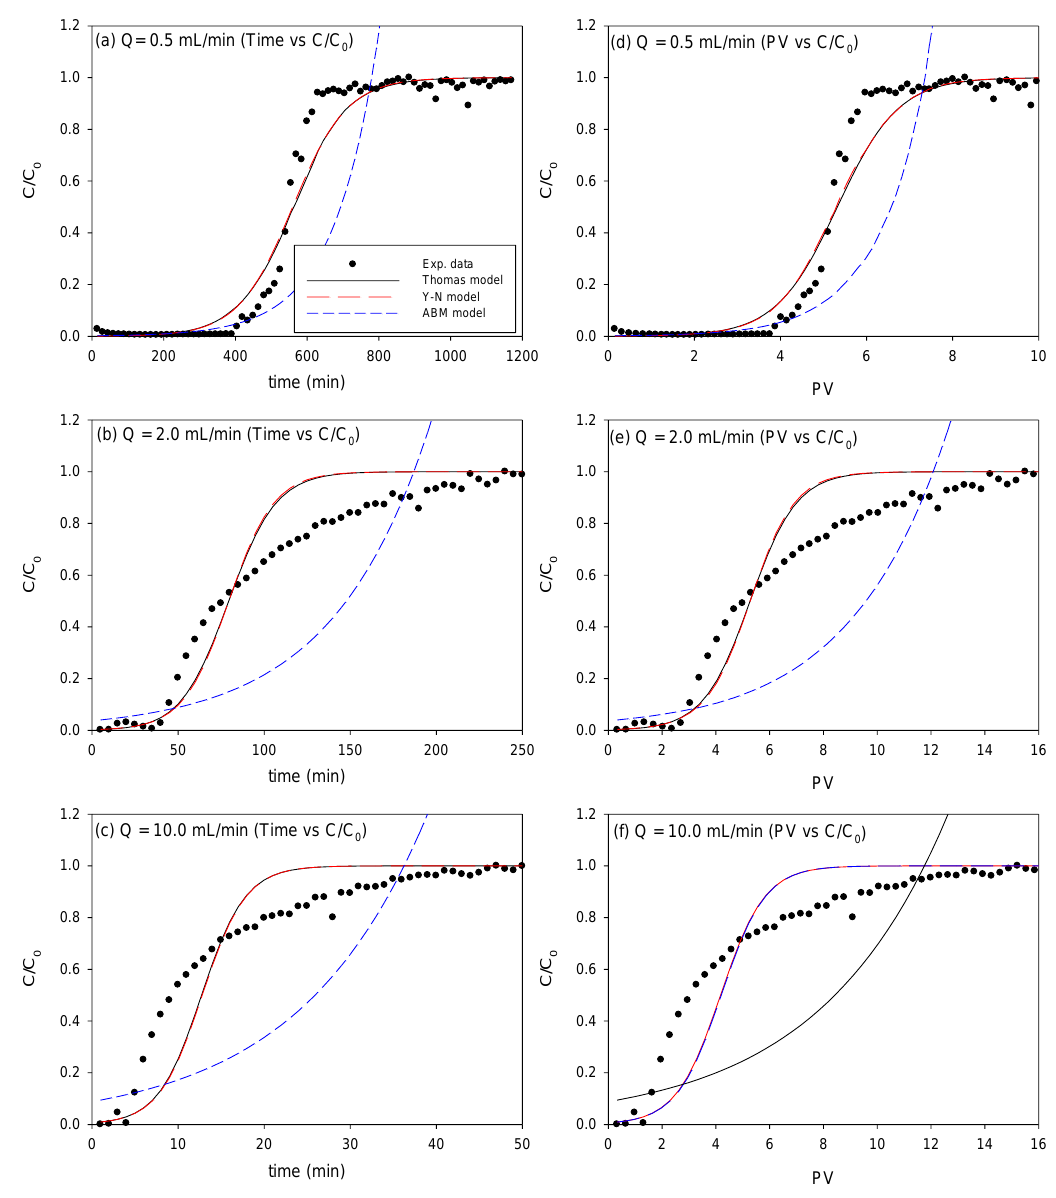
Figure 10. The effect of flow rate on the Pb adsorption breakthrough curves: ( a – c ) C/C 0 vs. time and ( d – f ) C/C 0 vs. PV. Table 3. Parameters of Thomas, Yoon-Nelson, and Adams-Bohart models for Pb